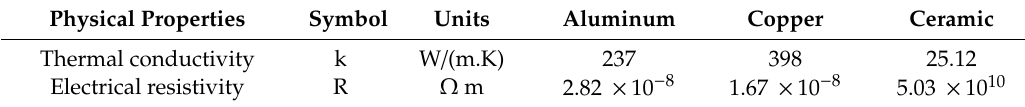
Table 1. Physical properties of aluminum, copper and ceramic.